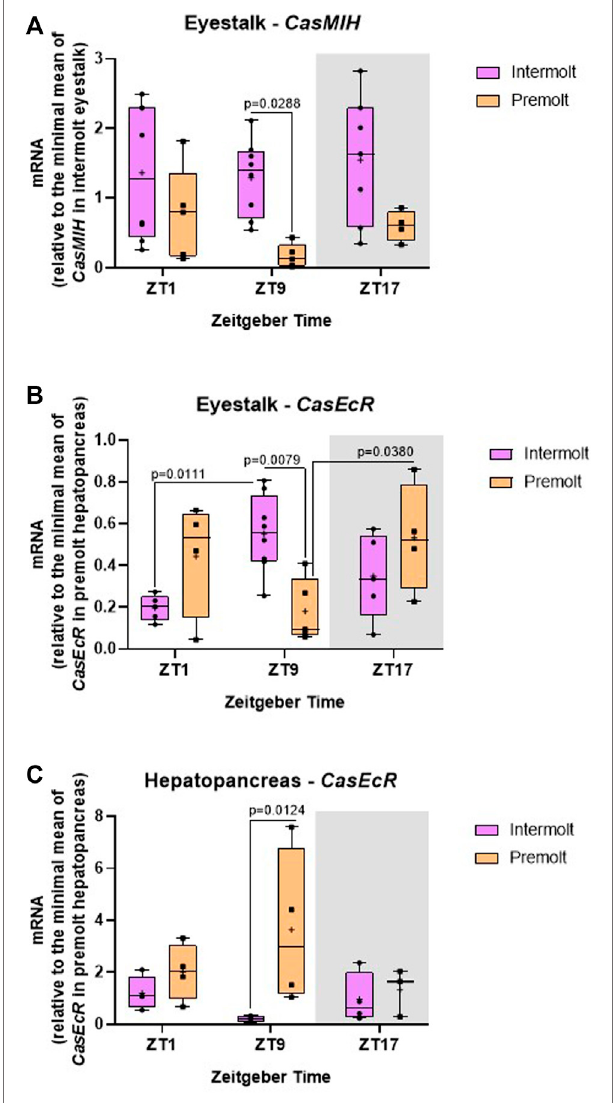
FIGURE 4 | Temporal gene expression in intermolt and premolt C. sapidus . (A) CasMIH ( n = 4 – 8) and (B) CasEcR ( n = 4 – 8) in the eyestalks, and (C) CasEcR ( n = 3 – 4) in the hepatopancreas. Total RNA was extracted 1, 9, and 17 h after lights on. Gene expression was normalized by CasRPL12 and the values of CasEcR and CasMIH were expressed relativeto the minimal mean of CasEcR in premolt hepatopancreas and of CasMIH in intermolt eyestalk, respectively. p values refer to the differences between molt stages, or temporal points within a single molt group, as determined by Two-way ANOVA, followed by Bonferroni